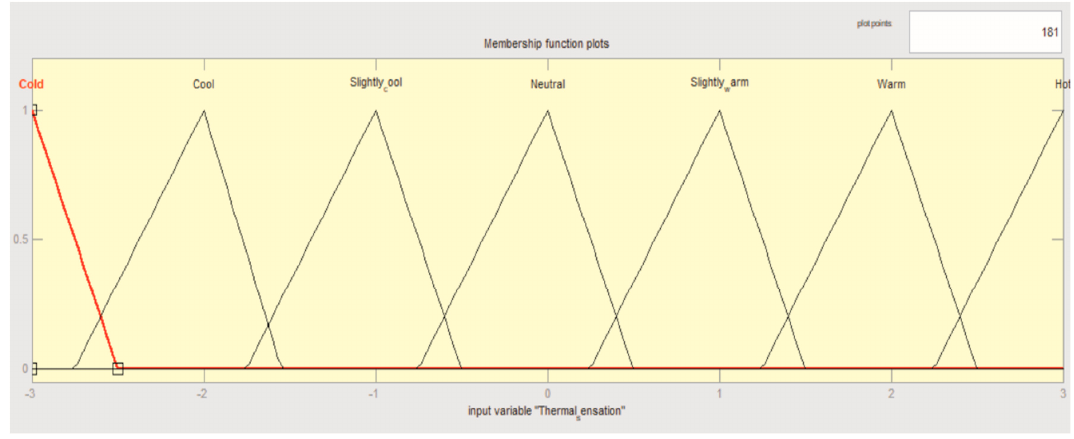
Figure 3. Membership functions of thermal sensation.